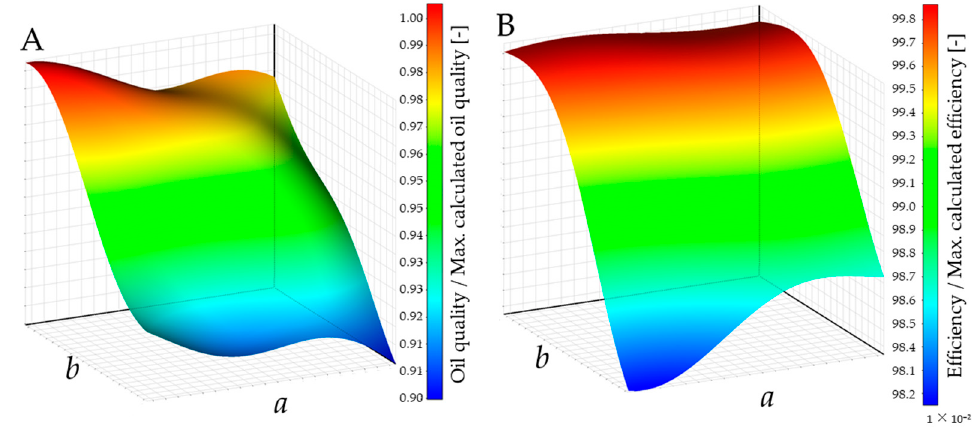
Figure 5. ( A ) Oil quality response surface; ( B ) Efficiency response surface.